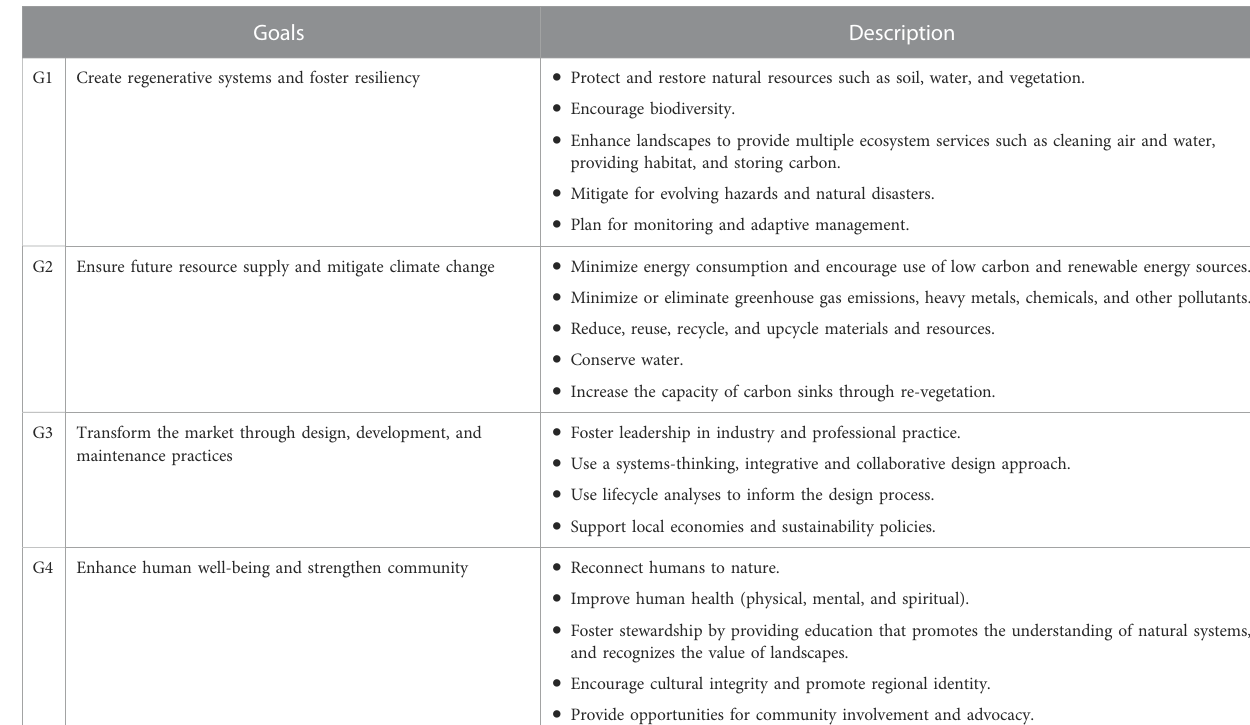
TABLE 1 Four goals of the SITES v2 rating